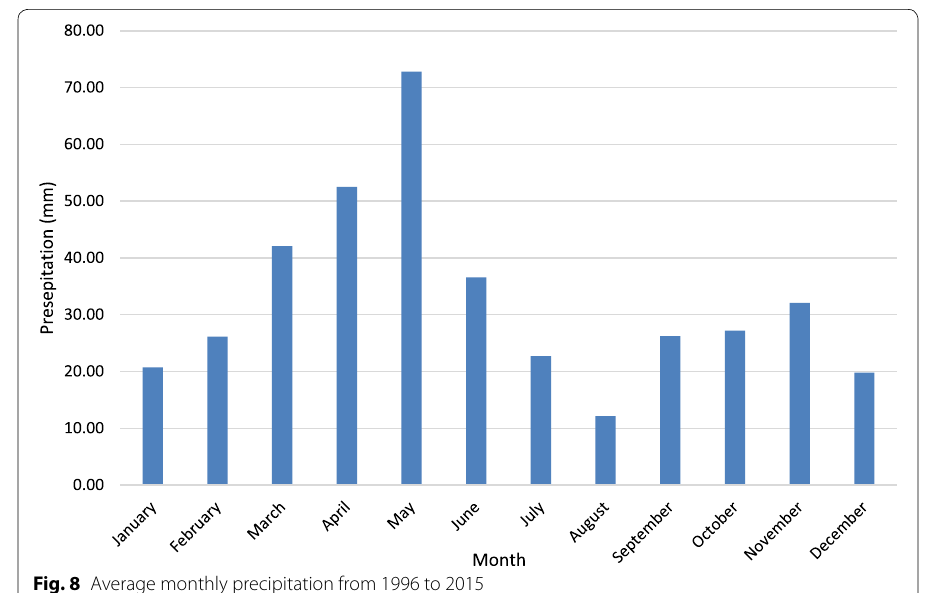
Fig. 8 Average monthly precipitation from 1996 to